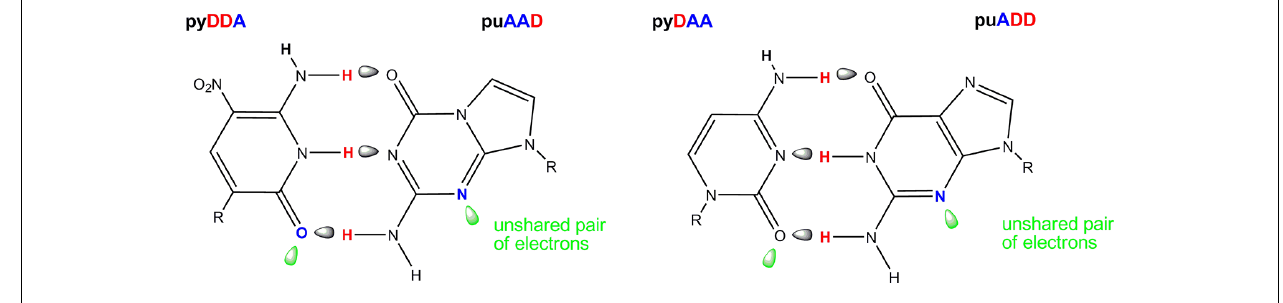
FIGURE 4 |The Z:P pair from an artificially expanded genetic information system (AEGIS, left) showing in green the orbitals containing the unshared electron pairs presented to the minor groove of DNA. The